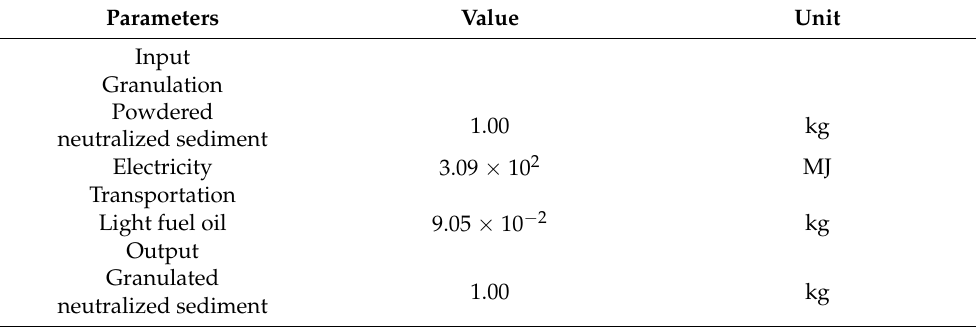
Table 5. Inventory data of granulated neutralized sediment, 1 kg.